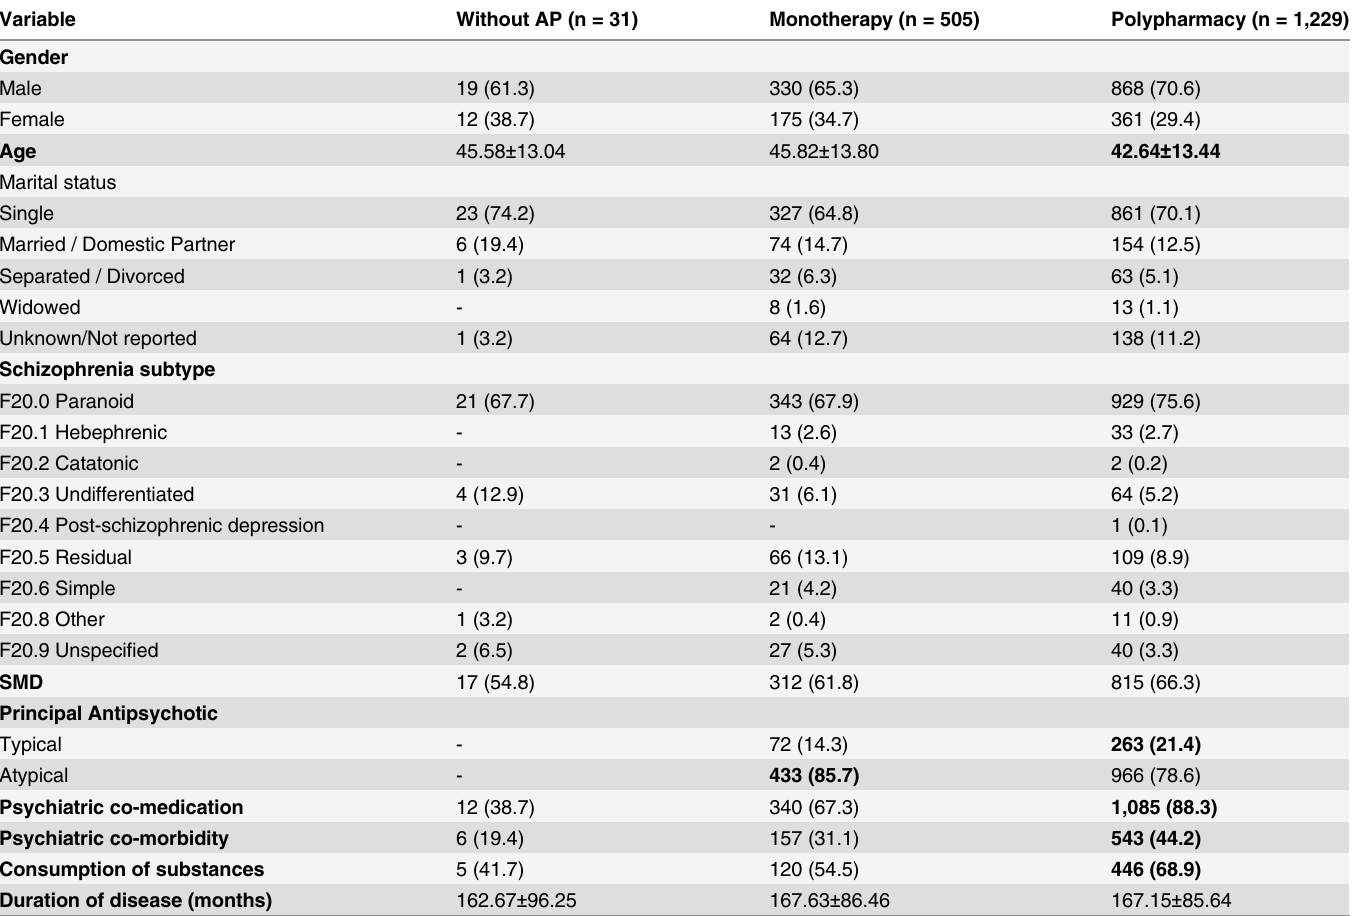
Table 1. Demographic and clinical characteristics and patterns of antipsychotic use in 1,765 outpatients with schizophrenia. Values are frequen- cies (%) or means ± standard